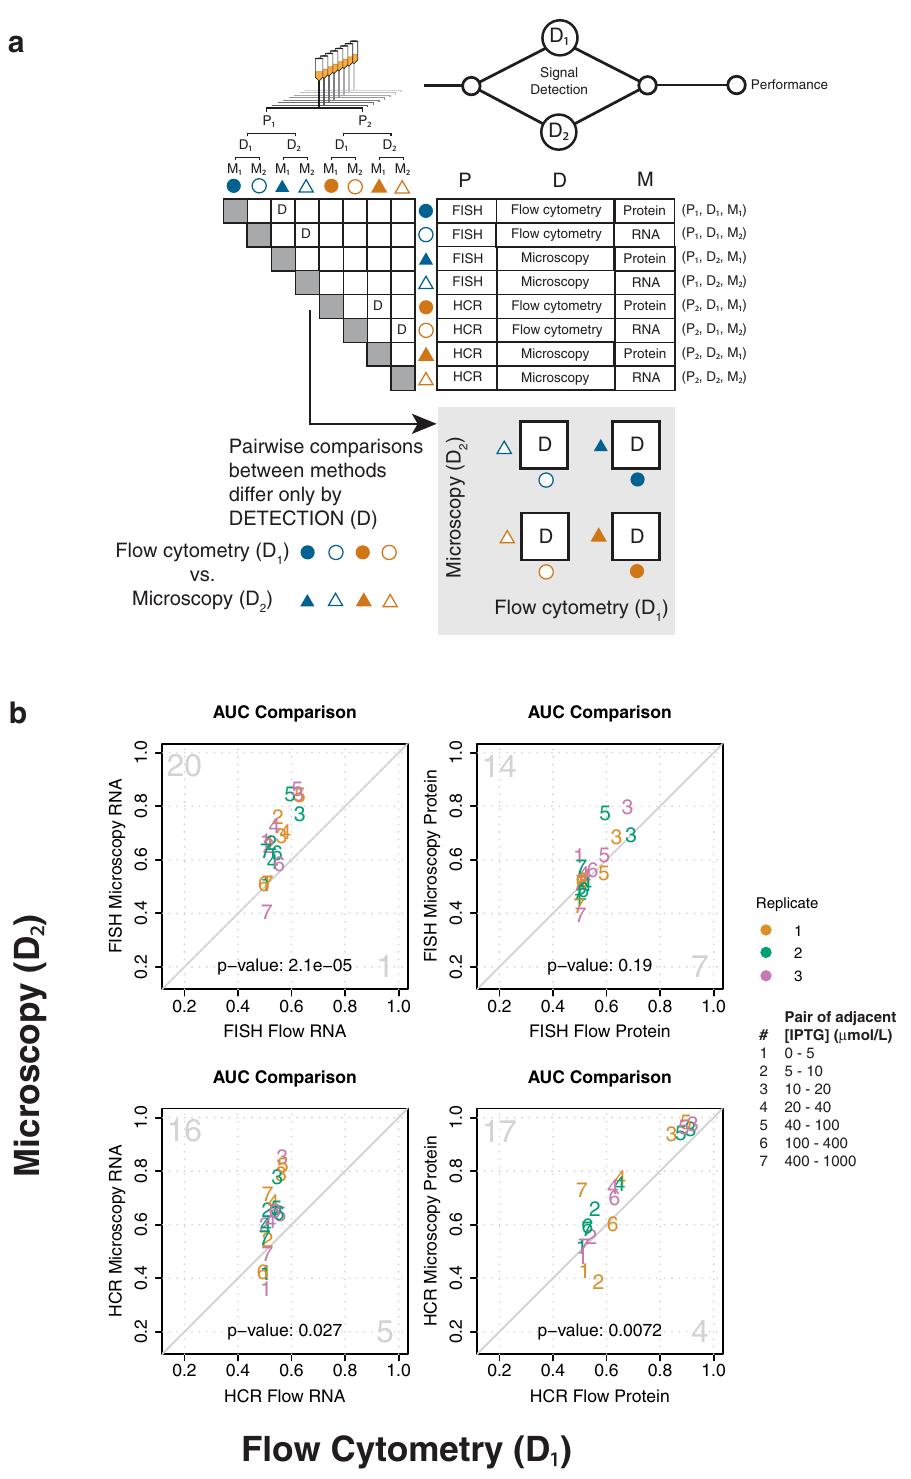
Fig. 4 Method performance can be attributed to signal detection. a Pairwise comparisons of methods that share the same steps for sample preparation and measurand, but differ in signal detection (indicated by “ D ” in the matrix), are used to attribute measurement performance to signal detection. The four boxes containing “ D ” under the matrix represent these same pairwise comparisons. b Pairwise AUC plots of measurements in ( a ) to compare resolvability between fl ow cytometry and microscopy. Diagonal line indicates equivalent resolvability between the two methods. Pairs of adjacent IPTG concentrations are shown as numbers within the plots, as indicated in the fi gure legend. Color indicates biological replicates one (orange), two (green), and three (purple), as indicated in the fi gure legend. Large gray numbers in the top-left and bottom right-corners indicate how many AUC ’ s were higher for the method plotted on the y -axis or x -axis, respectively. The two-sided p -values for a sign test are shown within each